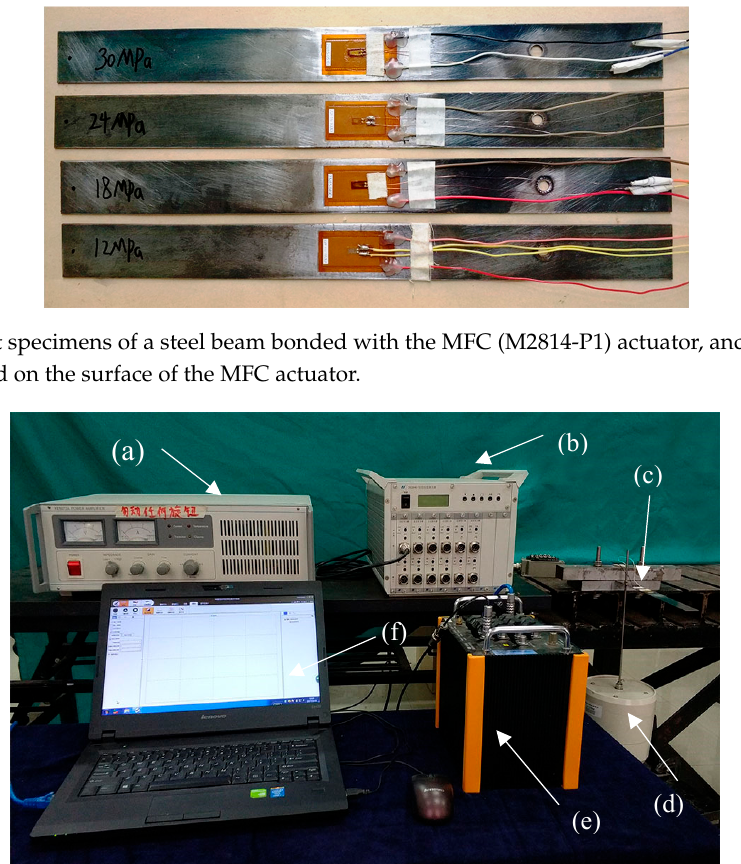
Figure 3. Photograph of the cyclic loading system for the MFC actuator. ( a ) Amplifier of shaker; ( b ) Dynamic strain gauge; ( c ) Steel beam with MFC; ( d ) Shaker; ( e ) Signal Acquisition System ( f ) PC.